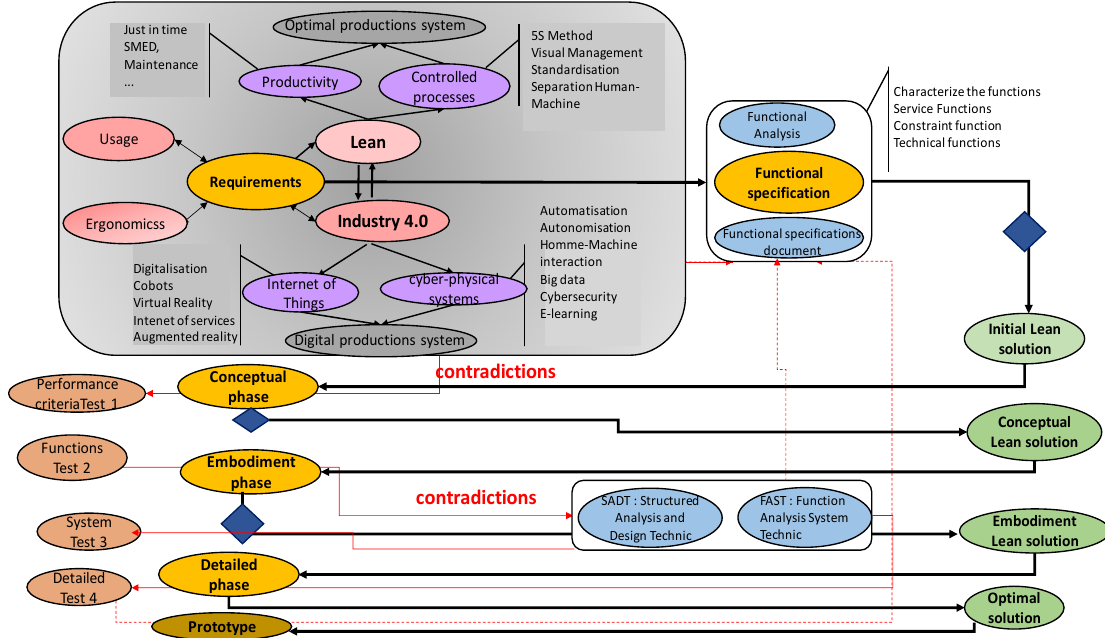
Figure 3. Lean-System-Design framework 1) Initialization phase: In this phase, the design problem is defined; data from Lean and Indus–try 4.0 can be